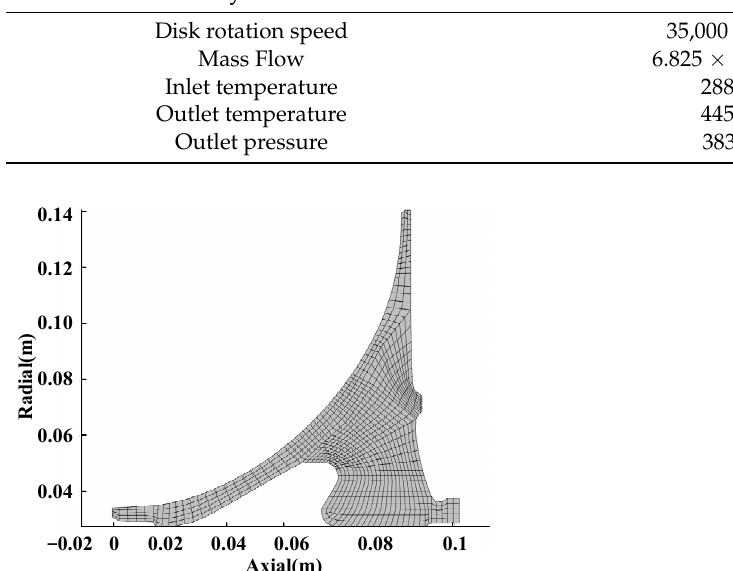
Figure 6. The quadrilateral mesh for PDTA on the radial–axial cross-section. Table 2. The material parameters of Table 1. Boundary conditions in the steady state.